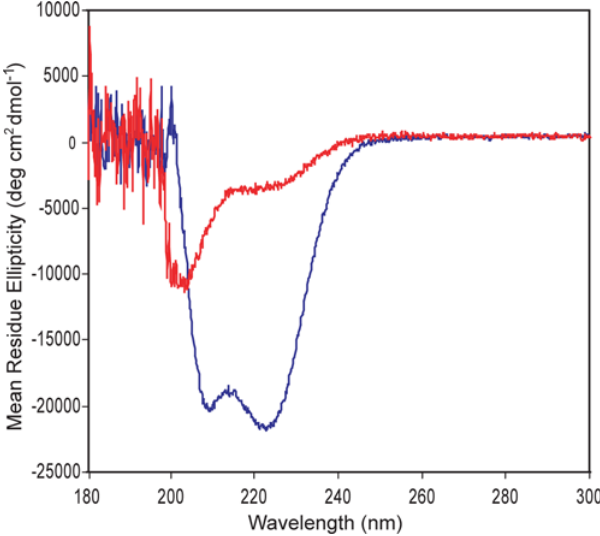
Figure 6. Circular dichroism. Spectra of ArntbHLH (red line) and ArntbHLH-C/EBP (blue line). 2 m M protein monomer was placed in 200 m L Buffer D (15.08 mM Na 2 HPO 4 , 4.92 mM KH 2 PO 4 , pH, 7.4, 50 mM NaCl). Samples were incubated overnight at 4 u C, followed by at least 20 min incubation at room temperature. Each spectrum was averaged twice, and curves were not subjected to smoothing. The buffer control was subtracted from each protein spectrum. Mean residue ellipticities are presented, which accounts for differences in lengths of the two proteins.